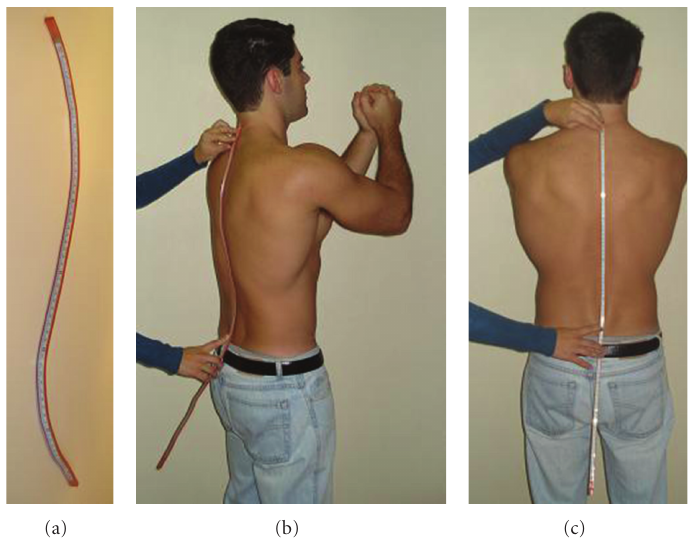
Figure 2: (a) Flexicurve; (b) molding the flexicurve to the spine, lateral view; (c) molding the flexicurve to the spine, posterior view.